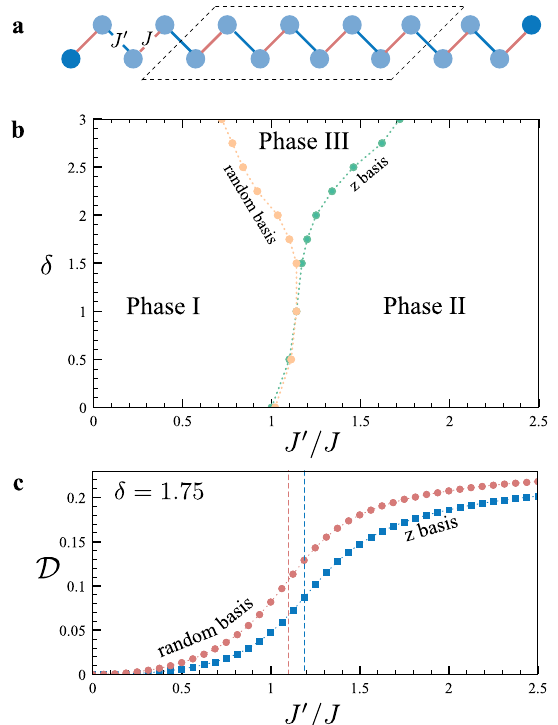
Fig. 9 Phase diagram of XXZ model. a Schematic representation of the bond-alternating 16-spin XXZ model. The spins in the central part of the chain denoted with the dashed line are measured to calculate the dissimilarities. b Phase diagram constructed by using the dissimilarity calculated in the σ z and the random bases. The phase boundaries are de fi ned as maximal values of the dissimilarity derivatives with respect to J 0 for a given δ . c Dissimilarities in the σ z (blue squares) and the random (red circles) bases calculated at the anisotropy value δ = 1.75. The vertical lines denote the positions of the maximum of dissimilarity derivatives with respect to J 0 .